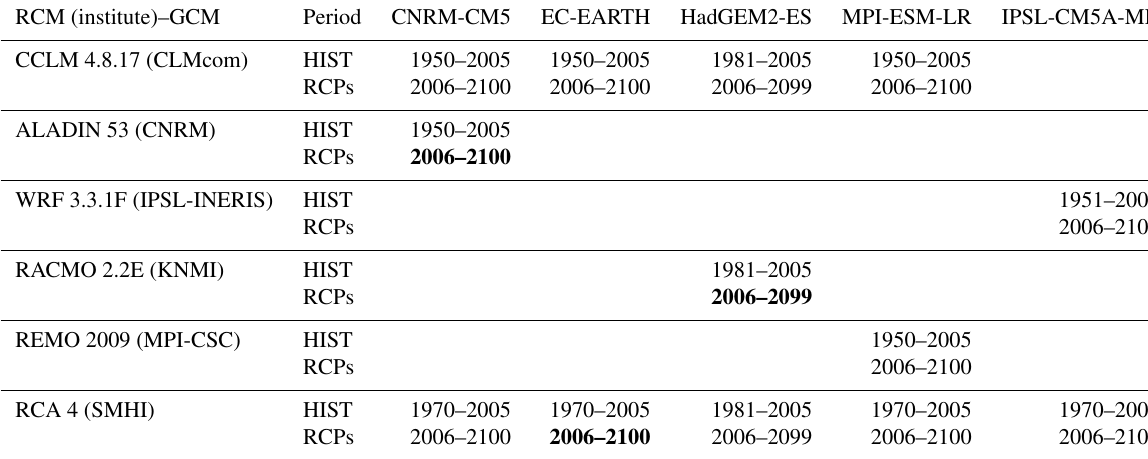
Table 1. EURO-CORDEX GCM–RCM combinations used in this study (rows: RCMs; columns: GCMs), with the time period available for the HIST and RCP4.5 and RCP8.5 scenarios (RCPs). Model combinations additionally using RCP2.6 are displayed in bold. Contributing institutes are indicated inside parentheses – CLMcom: Climate Limited-area Modelling Community with contributions by BTU,